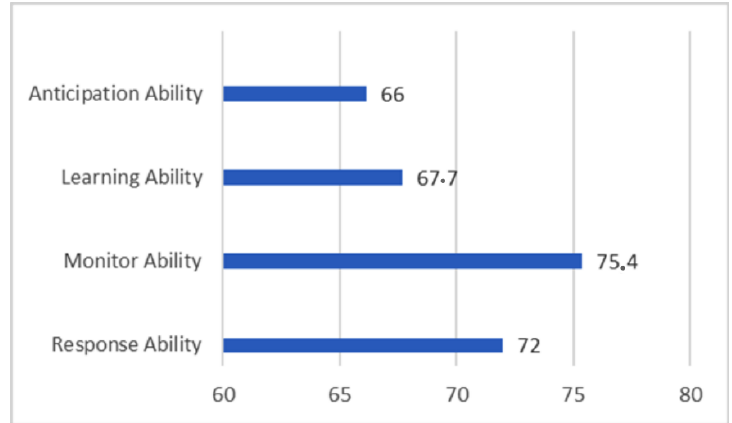
Figure 5. Average resilience safety level at the private company.